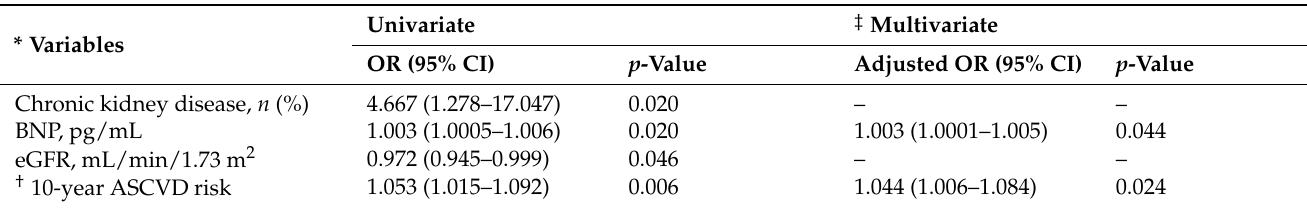
Table 3. Univariate and multivariate logistic regression analysis to evaluate the association between the high average size of choriocapillaris flow void and baseline characteristics with 10-year ASCVD risk.